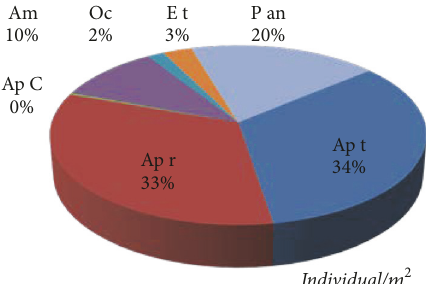
Figure 8: Earthworms’ global specific abundance